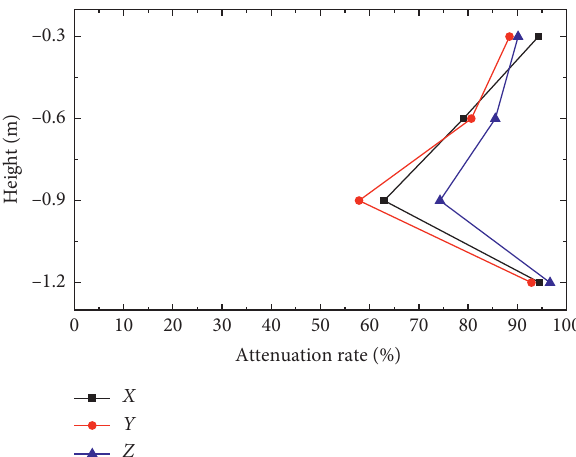
Figure 9: Attenuation of acceleration at different